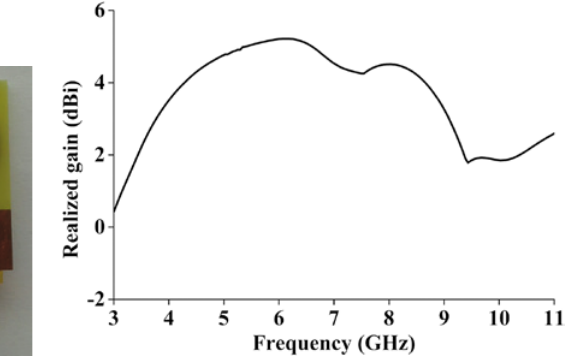
Figure 7: Effects of return loss for different values of S